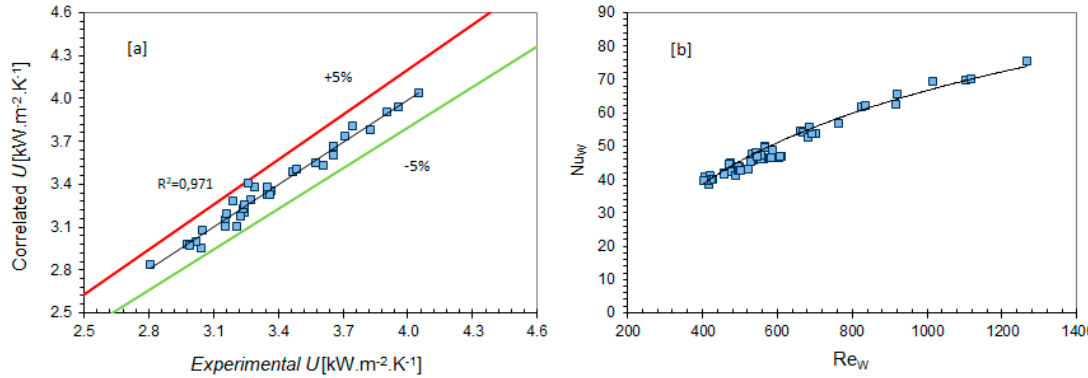
Figure 4. Predicted data vs. experimental data in the H-type PHE for ( a ) solution-side heat transfer coefficient; and ( b ) solution-side mass transfer coefficient.